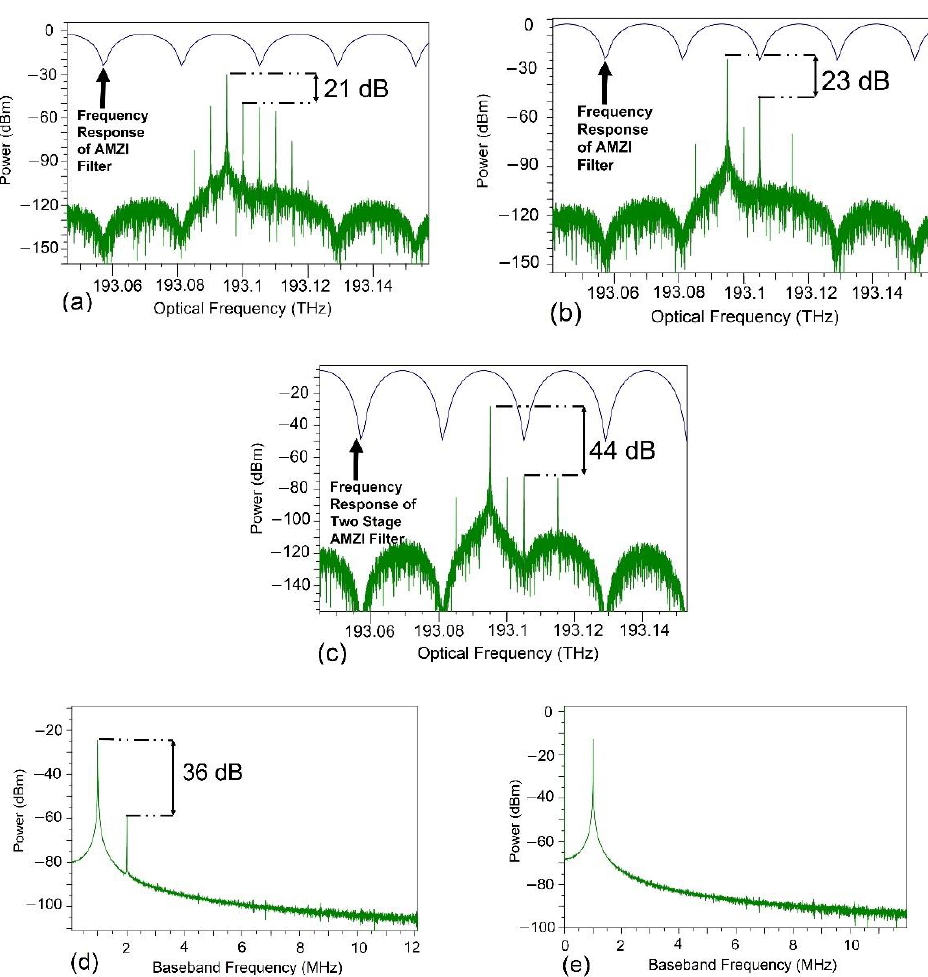
Figure 5. Frequency shift effect. SMSR after filter. ( a ) SE-MZM output optical spectrum. ( b ) DE-MZM output optical spectrum. ( c ) DE-MZM output optical spectrum filtered with two cascaded AMZI filters. ( d ) SE-MZM electrical spectrum of f IF , SMSR=36 dB. ( e ) DE-MZM electrical spectrum of f IF